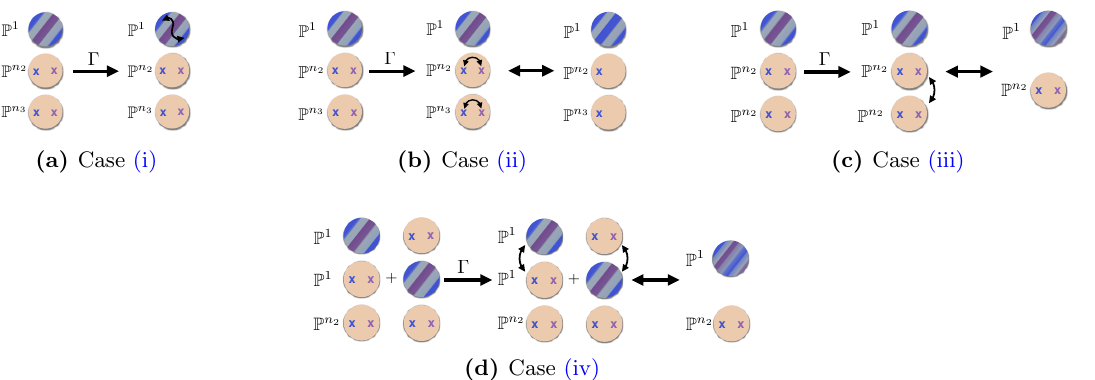
Figure 1. Schematic depiction of the di(cid:11)erent types of free quotient actions (i) to (iv). Blue dots represent the P 1 direction associated to the genus zero curves. The (cid:12)rst two columns of each diagram indicate the action of the symmetry. The last column represents the resulting con(cid:12)guration in the quotient